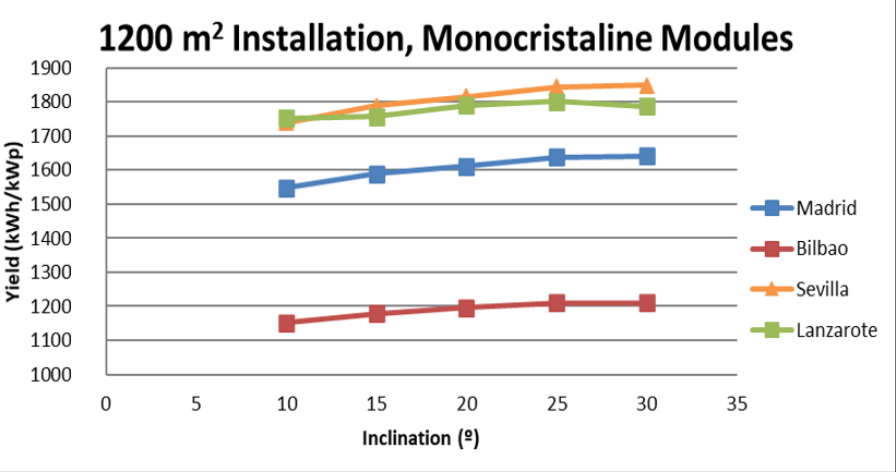
Figure 7. Yield as a function of inclination for each of the studied locations.